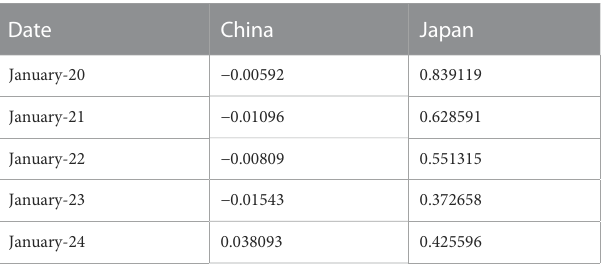
TABLE 12 Forecast results in China and